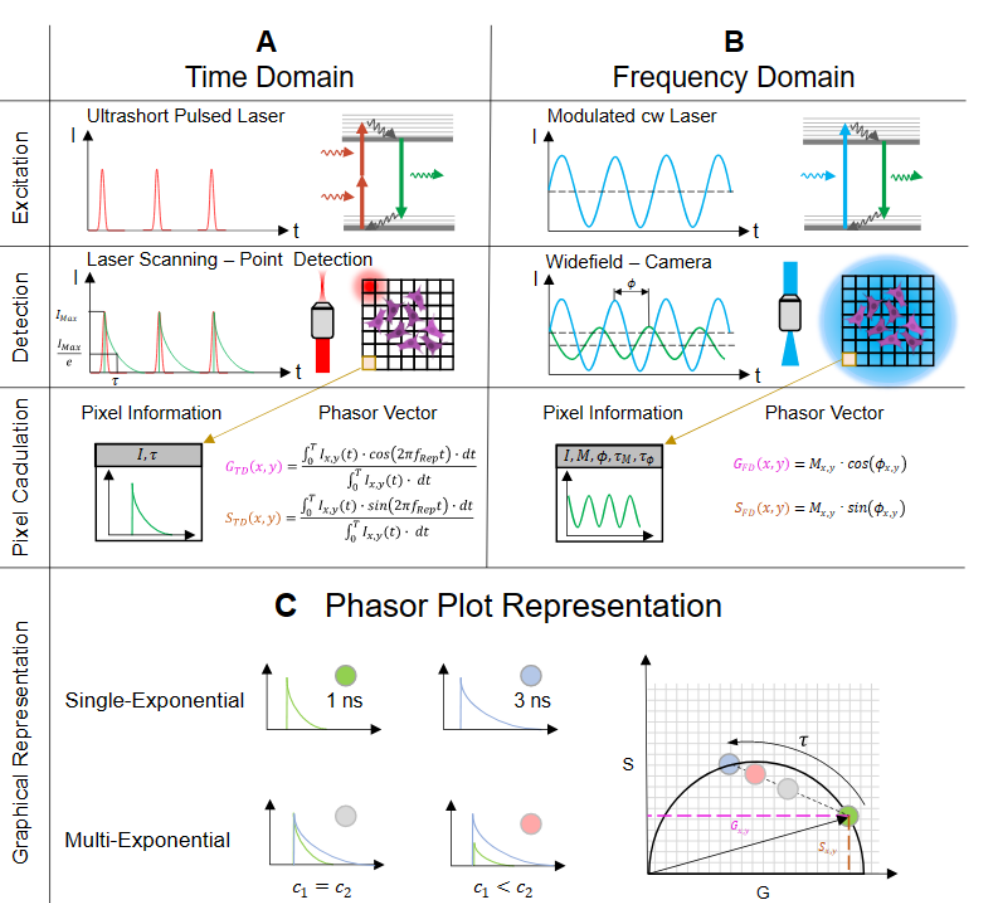
Figure 6. This figure shows both methods of obtaining the fluorescence lifetime in the ( A ) time- domain as well as in the frequency-domain ( B ). In the time-domain ( A ), a TCSPC device acts as a stopwatch and registers the time differences between the excitation (top row) and the arrival of the emitted fluorescence photon detected by a single photon detector (middle row). In the frequency- domain ( B ), the lifetime information is calculated by comparing the phase and amplitude between the modulated excitation (top row) and the modulated fluorescence of the sample (middle row). The obtained values in TD- and FD-FLIM (bottom row) are correlated by the Fourier transformation. ( C ) shows a way to represent both measurement results in a single plot, the so-called phasor plot. Each lifetime of a pixel is represented by a vector with the components G and S. Single exponential decays are located on the semicircle while multi-exponential decays are located within the semicircle. The position of the point cloud along the connection line between the two dyes indicates the concentration ratio c between